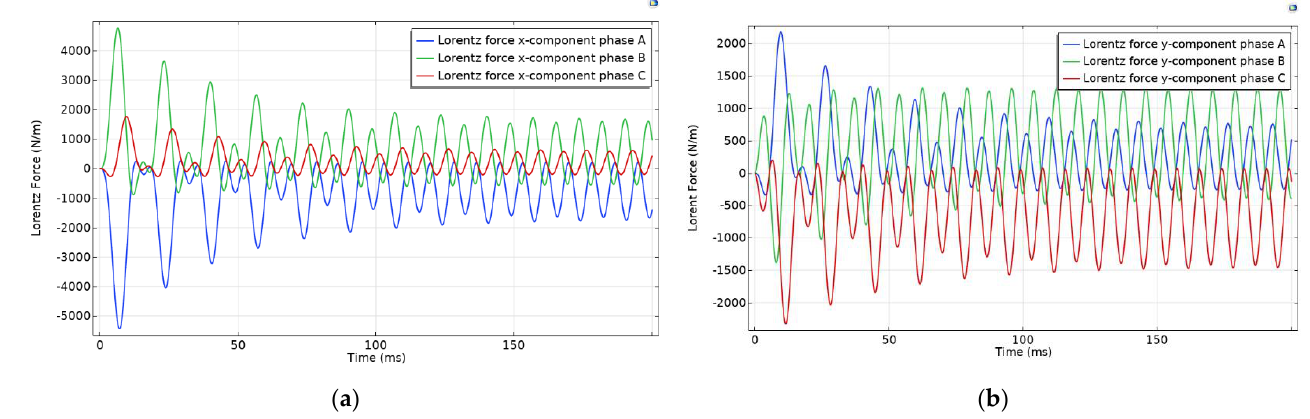
Figure 14. Electrodynamic forces on model 2 at 60 Hz: ( a ) in x direction; ( b ) in y direction. The electrodynamic forces on the busbars of model 6 are shown in Figure 15.